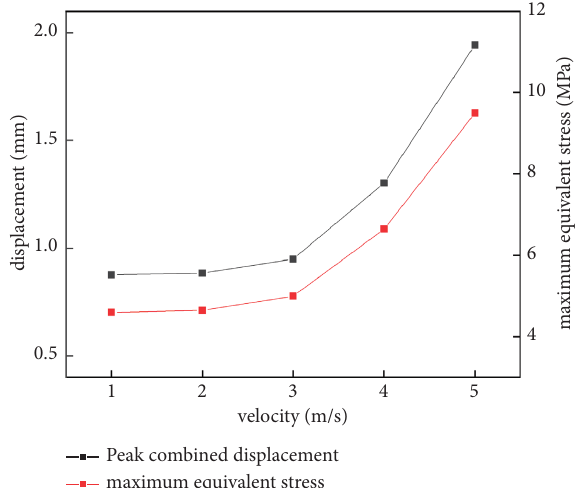
Figure 10: Variation curve of peak combined displacement and maximum equivalent stress with natural gas velocity.